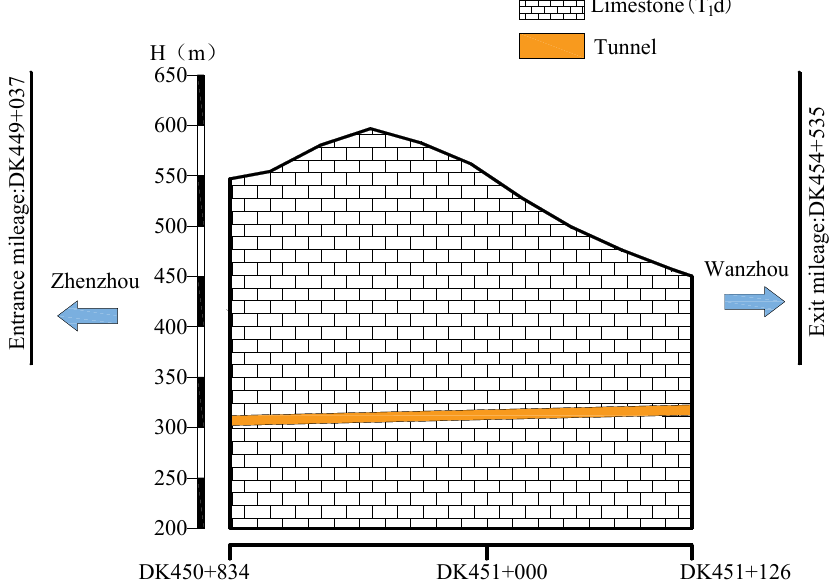
Figure 13. Test section of Gaojiaping Tunnel.